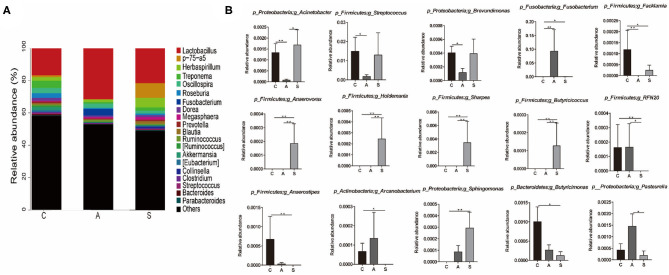
Effect of maternal synbiotic supplementation on the colonic microbial community structure in suckling Bama mini-piglets. Colonic microbiota distributed at the genus level (A) and only the top 20 genera were listed. A comparison of relative abundances at the genus level (B) was analyzed by Metastats analysis. The 20 most abundant bacterial genera with a clear classification status were presented and compared. *P < 0.05; **P < 0.01. n = 8 per group.